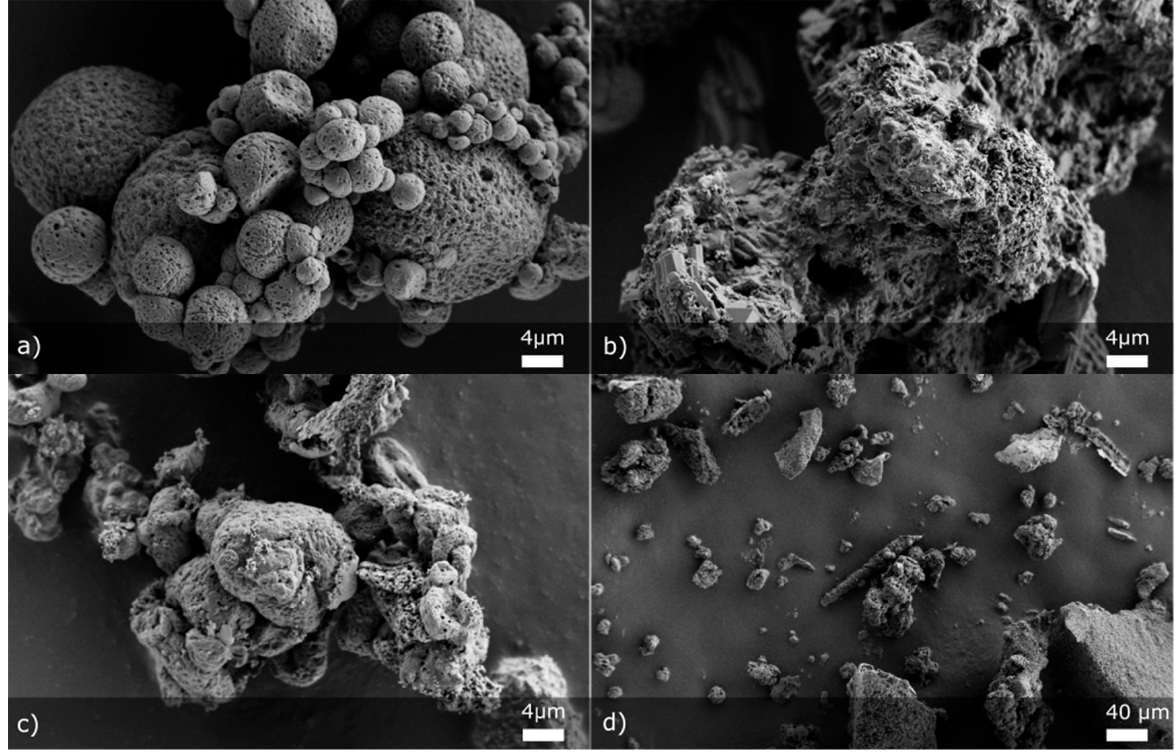
Figure 7. SEM micrographs of four experiments with two different magnifications: ( a ) F1, ( b ) F14, ( c ) F17 (all three 5000× magnification) and ( d ) F14 (500× magnification).